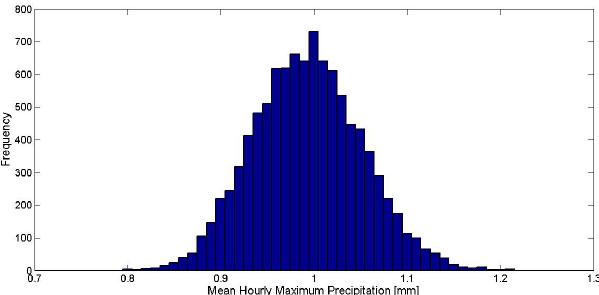
Fig. 5. Statistical sampling distribution of the sample mean maxi- mum PRT observation added to twice the sample standard devia- tion.